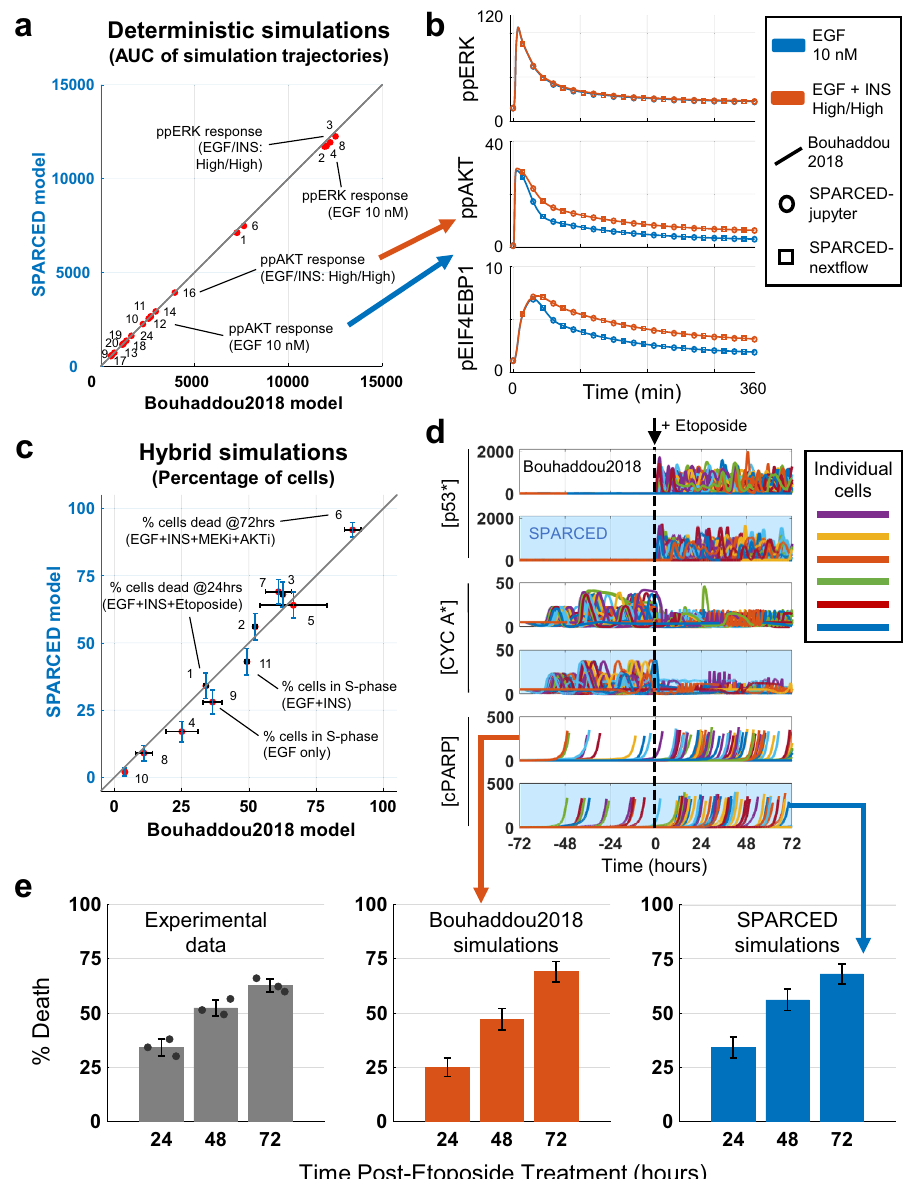
Fig. 3 SPARCED model recapitulates experimental observations and deterministic/hybrid (deterministic + stochastic) simulation results of the Bouhaddou2018 model. a Summary of comparisons of SPARCED model deterministic simulations to Bouhaddou2018 model simulations. The area under the curve (AUC) values of each simulation (see Supplementary Fig. 12) are calculated and plotted for the two model results. b Simulation results from Bouhaddou2018 model (line) and SPARCED-nf model (triangle) run on Kubernetes cluster work fl ow are the same as SPARCED model (circle) results. Comparisons of selected panels from ( a ) are shown only. c Experimental and stochastic simulation results from Bouhaddou2018 model are reproduced by SPARCED model simulations. Each dot is a different condition, explained in Supplementary Fig. 13a. Error bars show experimental or simulation standard error of the mean. Simulations are of at least 100 cells, and three independent experimental observations where applicable. d Stochastic simulation of 100 cells recapture protein level trajectories (active p53, Cyclin A, and cPARP) from older model qualitatively. Panels with blue background are SPARCED simulations and white background panels are from Bouhaddou2018 model. 100 stochastic cells are stimulated with EGF + Insulin for 72 h before Etoposide treatment for another 72 h. Etoposide is stimulated also with EGF + Insulin. Results for Etoposide treatment without prior growth factor stimulations are shown in Supplementary Fig. 13b. e Quanti fi cation of results in ( d ) shows that SPARCED model simulations coincide with earlier observations in percentage of death induced by etoposide treatment. See Supplementary Fig. 13c for the effect of no growth factor stimulation before Etoposide treatment. Gray bars represent mean ± s.e.m. of three independent biological replicates (dots). Blue and orange bars represent the percentage of dead cells at speci fi ed time ± s.e.m. Source data are provided in Source